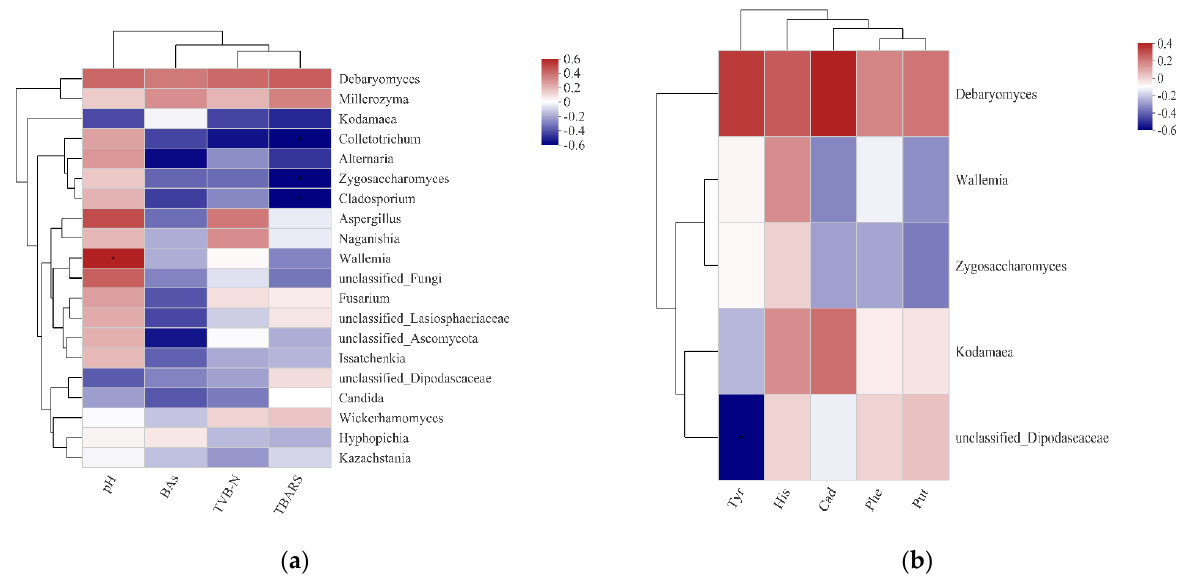
Figure 5. Correlation analysis between the fungal genera and physicochemical properties in the Suanyu samples ( a ). Correlation analysis between the fungal genera and five biogenic amines in the Suanyu samples ( b ). Note: * indicates p < 0.05; TVBN: total volatile base nitrogen; TBARS: thio- barbituric acid reactive substance; BAs: biogenic amines; Phe: phenethylamine; Put: putrescine, Cad: cadaverine; His: histamine; Tyr: